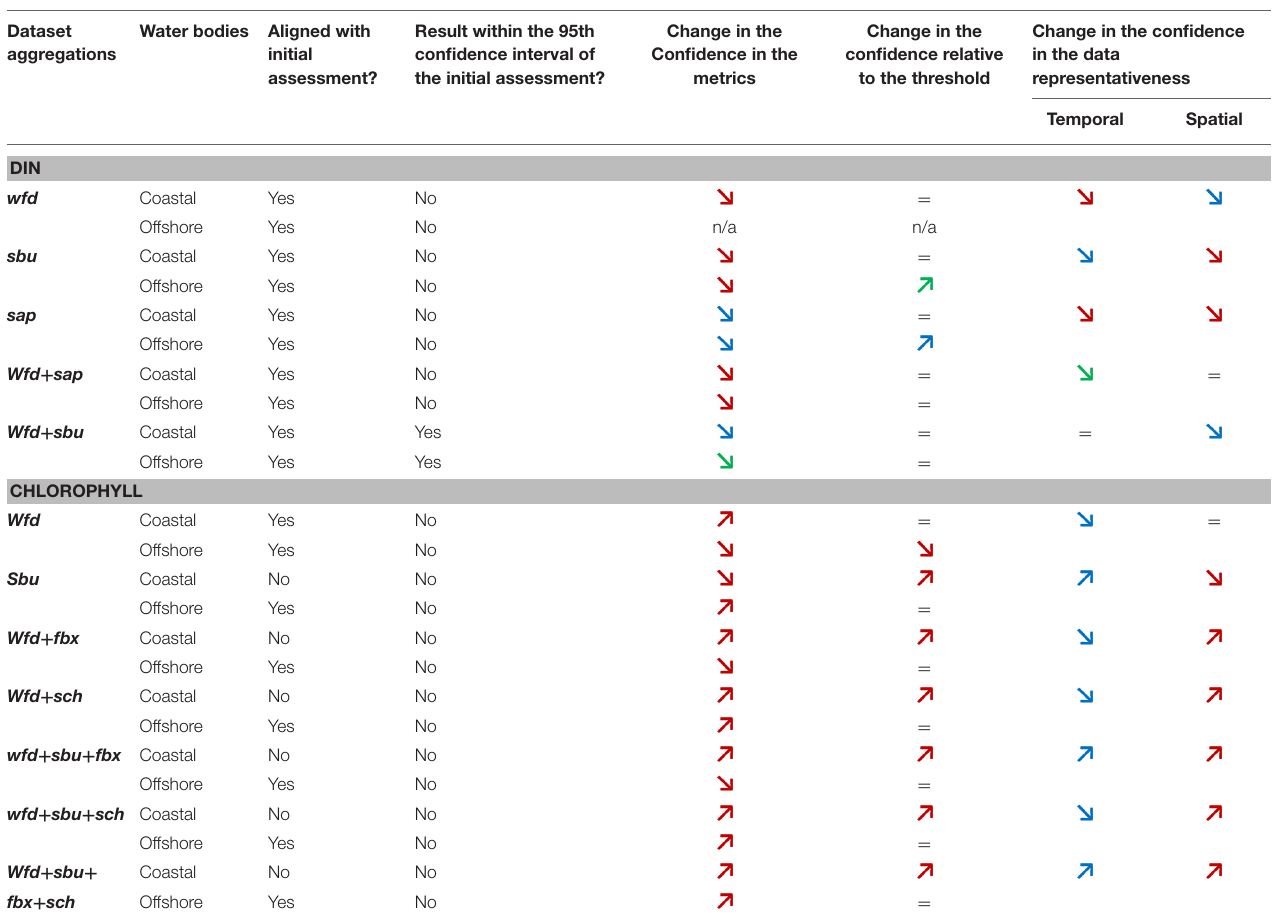
TABLE 6 | Summary of the changes with respect the reference assessement of the different aggregation